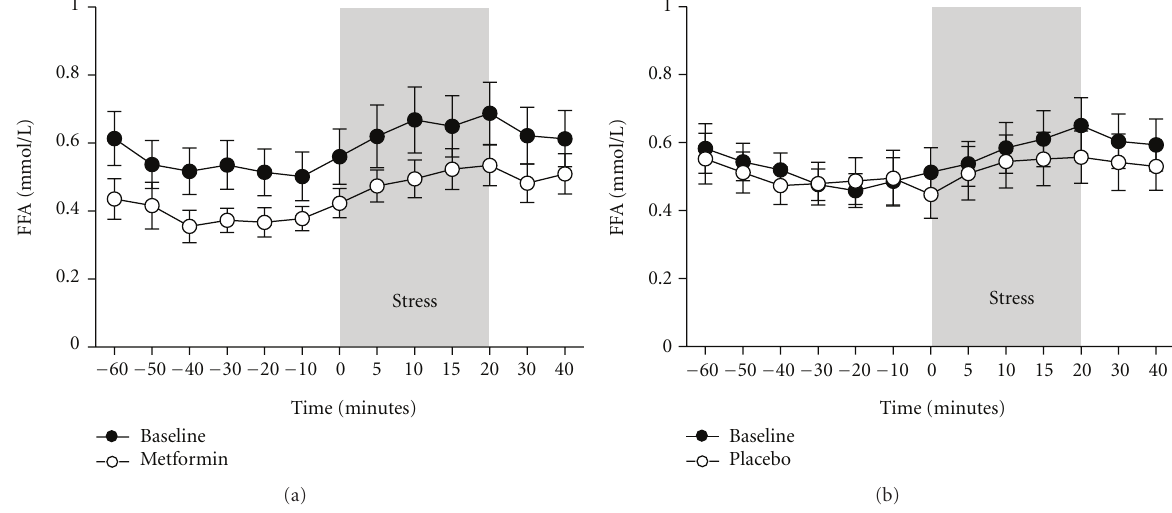
Figure 1: Mean changes in free fatty acid (FFA) concentrations during the mental-stress test (MST) in insulin resistant patients at baseline and after six weeks of treatment with metformin ( N = 10) (a) or placebo ( N = 9) (b). Data represent the mean ± SEM.